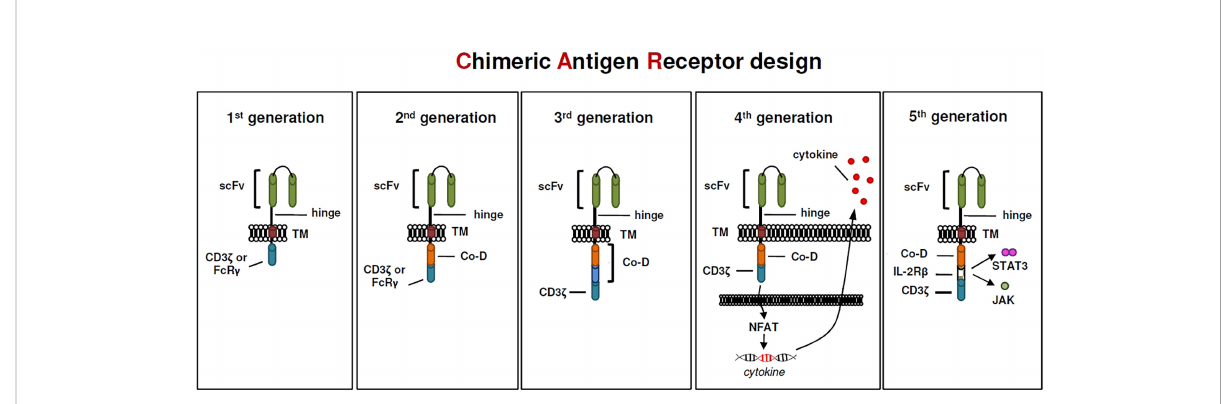
FIGURE 1 The evolution of